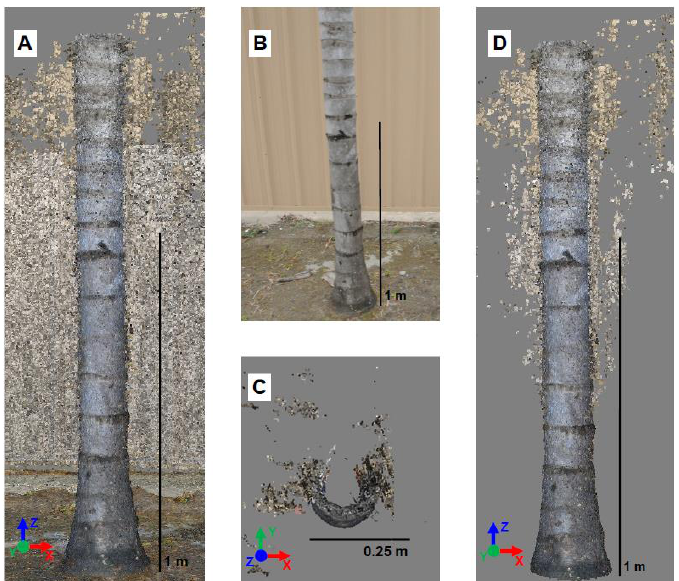
Figure 8. A stem modeled in PhotoScan with a highly uniform background. ( A ) A point cloud of a stem from the perspective of the roadway; ( B ) an image of the stem used to create the point cloud; ( C ) the stem from the perspective of above demonstrating error points around the stem from poor depth discrimination from the nearby background; ( D ) the stem from the perspective of the roadway demonstrating error points around the stem from poor depth discrimination from the nearby background.